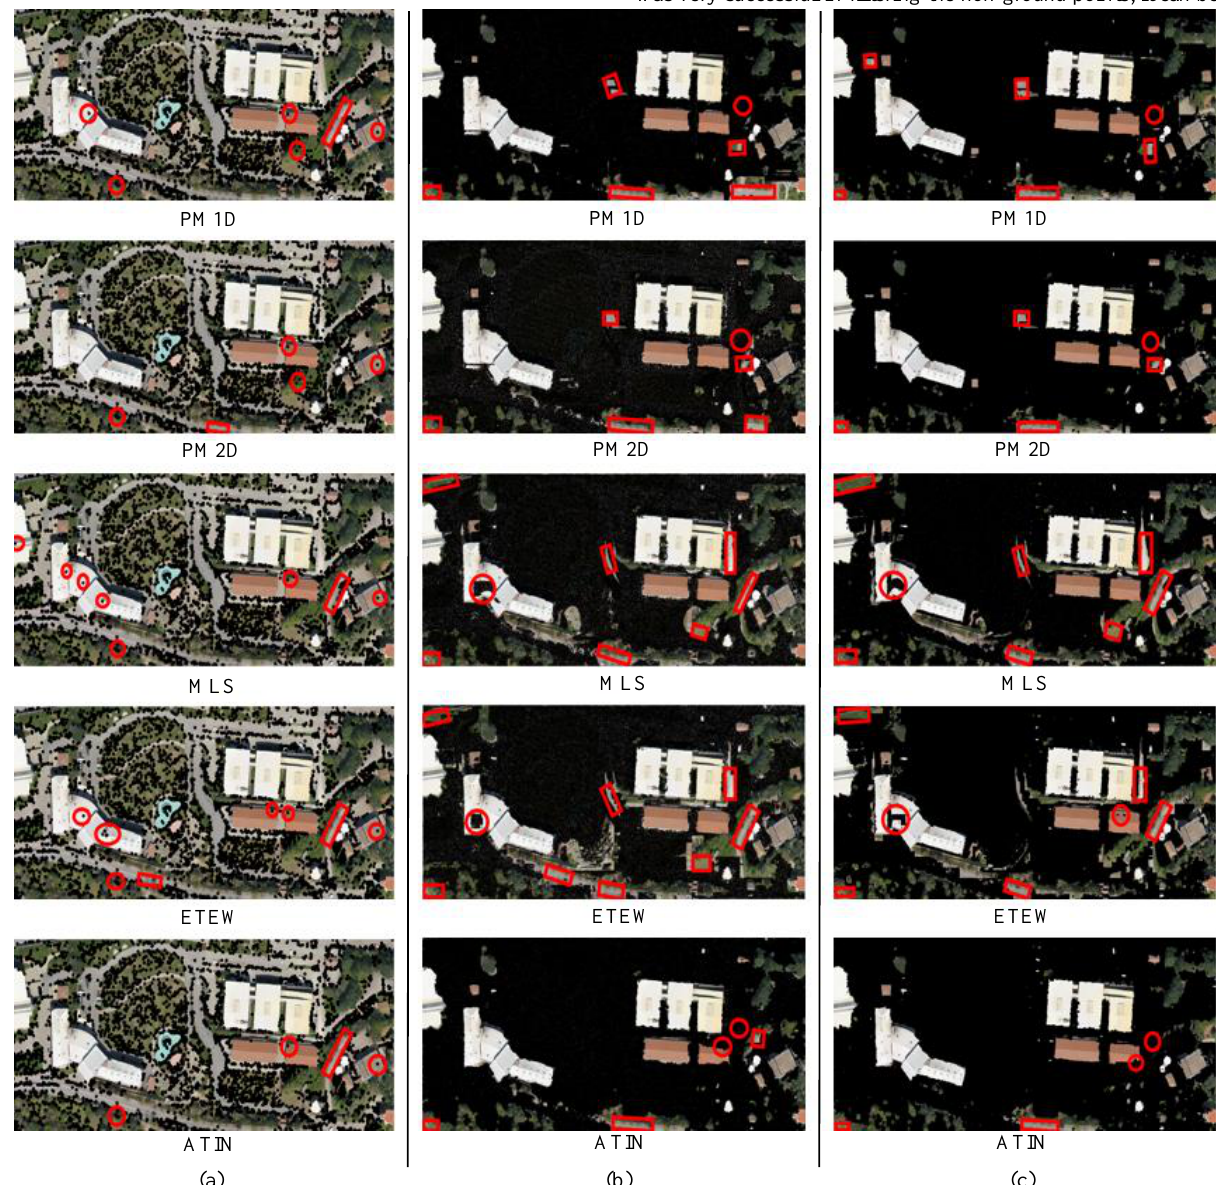
Figure 2. Filtering results of the raw (a), medium-density (b) and high-density (c) point